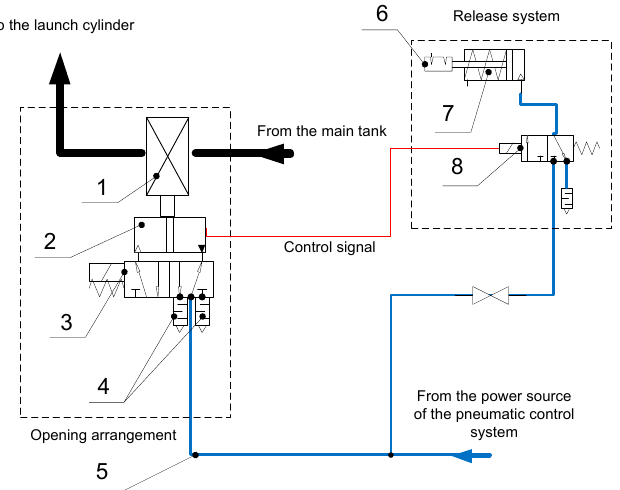
Figure 2. Diagram of the pneumatic control and drive system of the launch tube: 1—main ball valve, 2—shuttle actuator (main ball valve drive), 3—5/2 valve, 4—silencer, 5—power cord, 6—starter carriage release lock, 7—single ‐ acting pneumatic actuator, 8—valve 3/2.